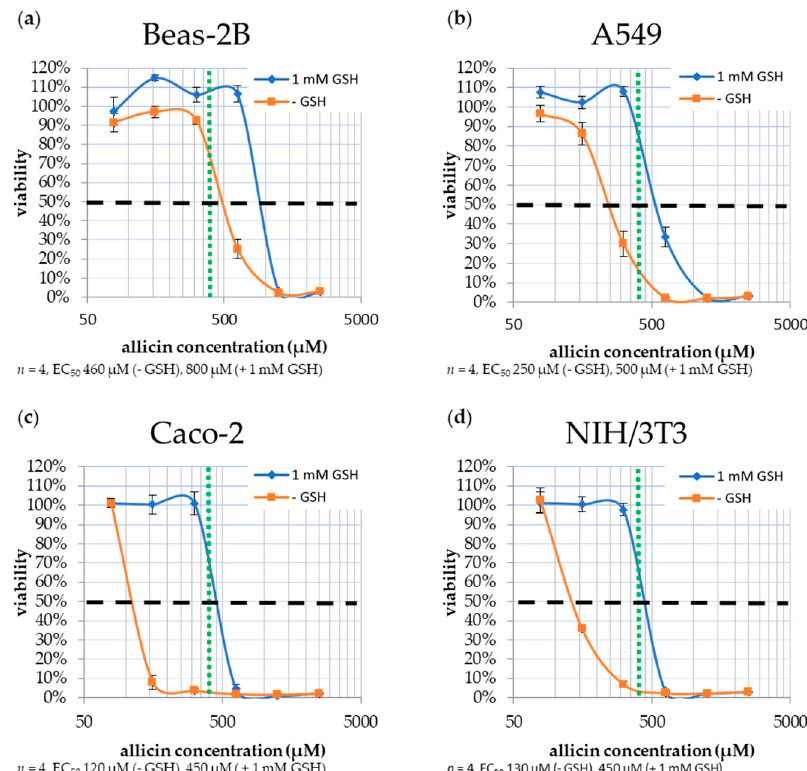
Figure 3. Susceptibility of mammalian cell lines to allicin. Cell cultures were stressed for one hour by exposure to allicin at different concentrations, either in the absence or presence of 1 mM reduced glutathione (GSH). Cell viability was determined with the MTT-(3-(4,5-dimethylthiazol-2-yl)-2,5- diphenyltetrazolium bromide)-test. The half maximal effective concentration (EC 50 ) for allicin was determined and is marked with a horizontal dashed line (- - - - -). The MIC value for the majority of tested bacteria (390 µM allicin, 64 µg/mL) is marked with a vertical dotted line (………). ( a ) Beas-2B (SV40-immortalized human bronchial epithelial cells); ( b ) A549 (human epithelial lung carcinoma); ( c ) Caco-2 (human epithelial colon tumor) and ( d ) NIH/3T3 (murine embryonic fibroblast), respectively.